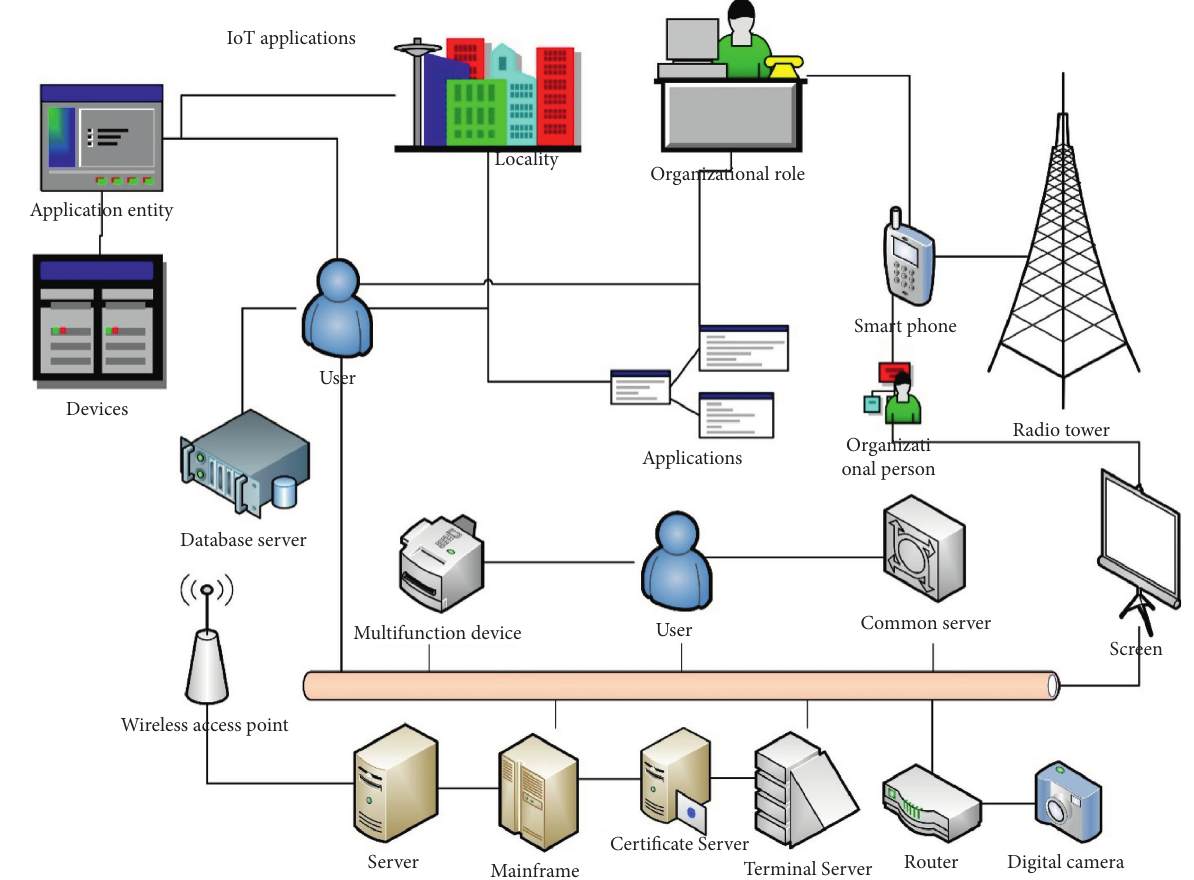
Figure 1: Generic overview of